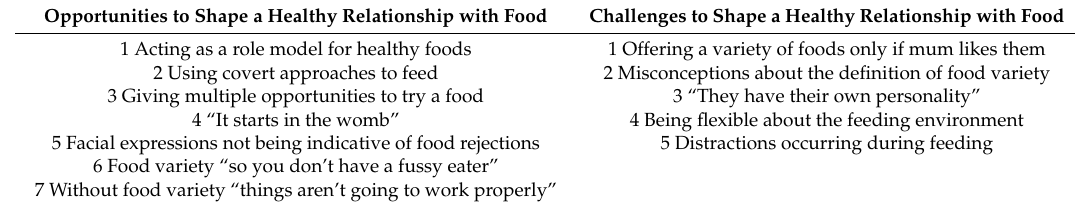
Table 3. Summary of the opportunities and challenges to establish a healthy relationship with food, as emerged from the interviews ( n =